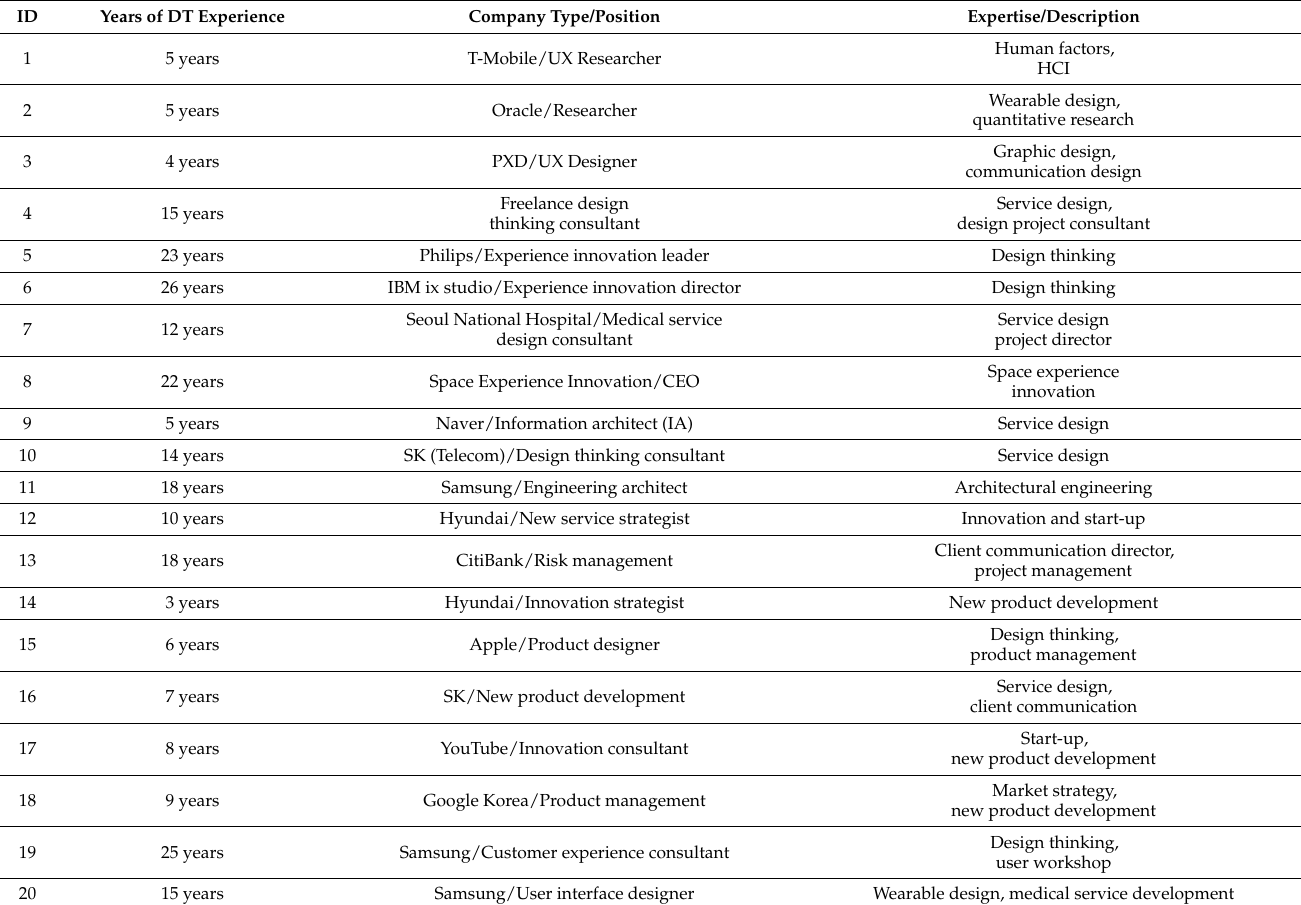
Table 1. Background description of the